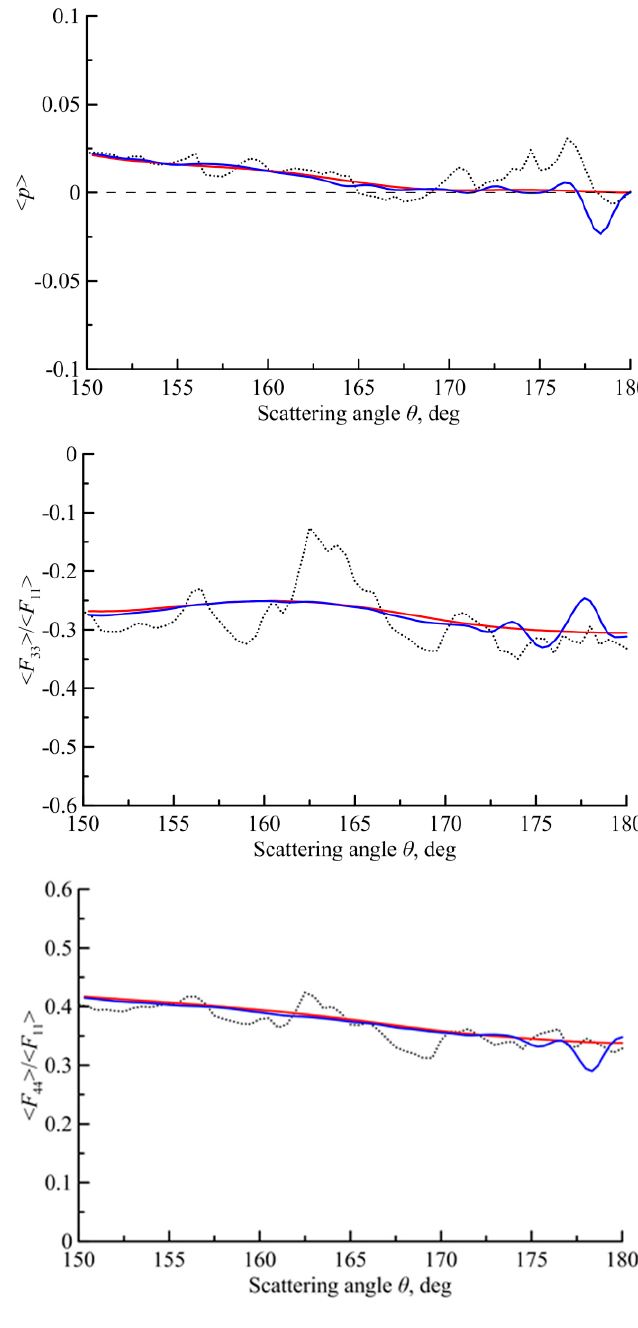
Figure 2. The scattering matrix for the shape 1 of Figure 1.